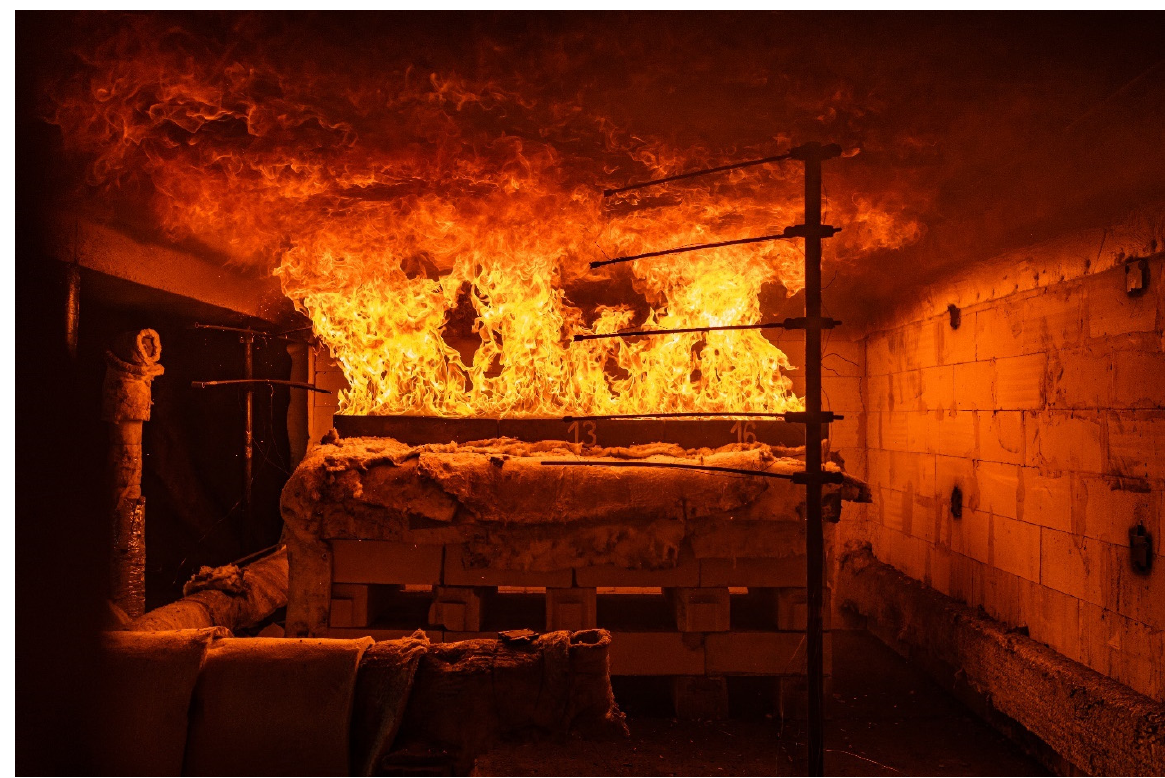
Figure 18. Flaming of the CLT ceiling in Experiment 3 during the 1250-kW steady phase.